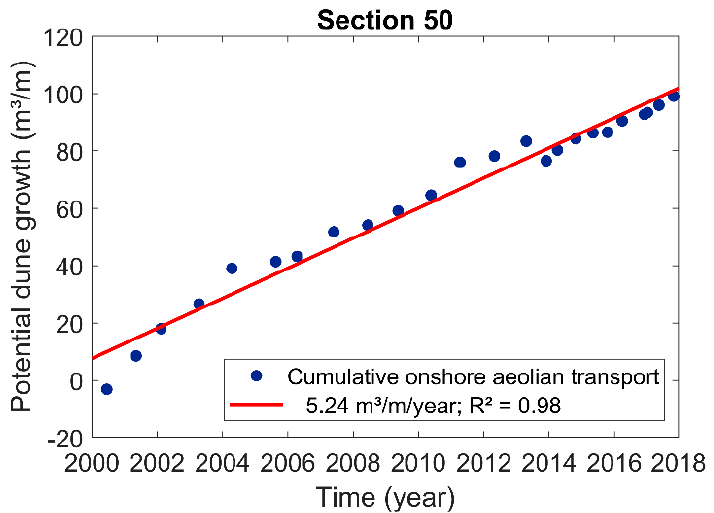
Figure 25. Annual potential longshore and onshore aeolian sediment transport, based on the period between 2000–2017. 4.4. Correlation Between Potential Transport and Dune Volume Changes 4.4.1. Correlation on Annual Timescales More wind induces more aeolian sediment transport and intuitively, therefore, more dune growth is expected [4]. To find a correlation between variation in potential transport and dune volume change on an annual timescale, the Pearson correlation coefficient is calculated. In this procedure, three methods are applied to calculate the correlation coefficient: • Method 1: The first method compares dune erosion and dune growth with corresponding potential transport. Net potential transport is calculated based on the full wind rose (onshore and offshore winds).